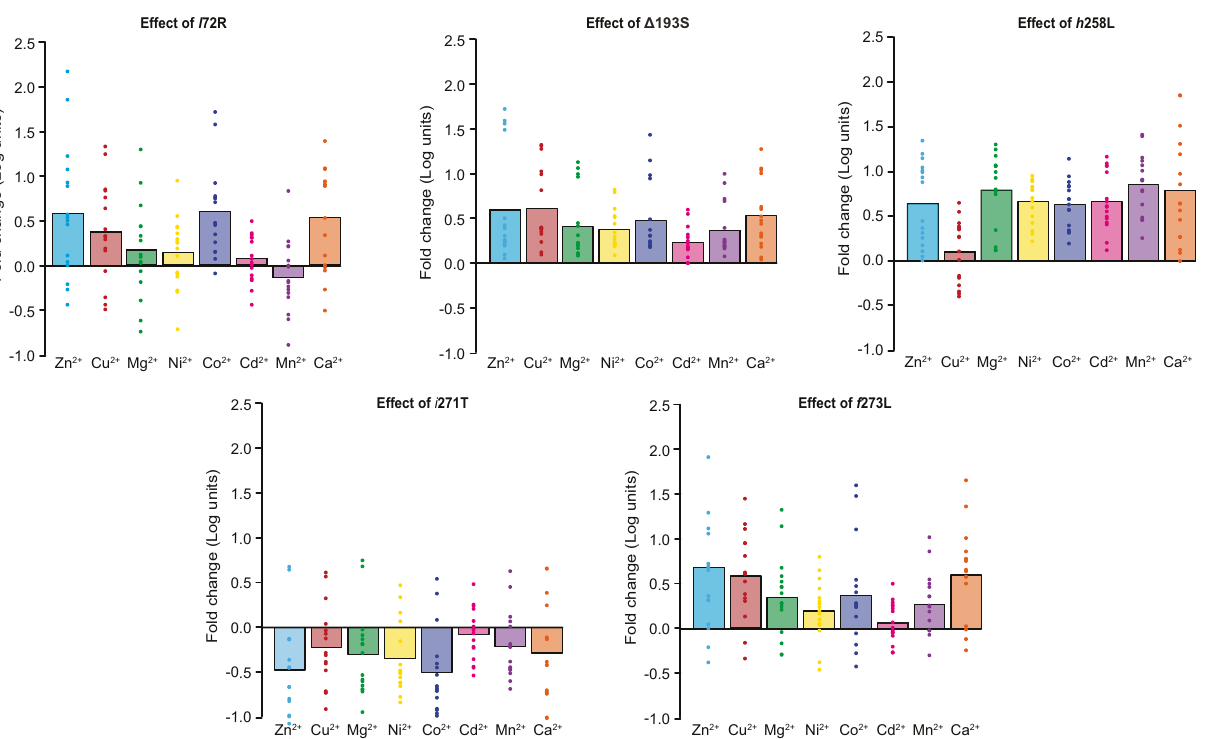
Fig. 4 The average effect of each of the fi ve historical substitutions when introduced in different metal environments. Average effect is shown with solid bars while the effect of each mutation introduced in the 16 alternate genetic backgrounds is shown with dots (each bar therefore representing the corresponding average across all 16 dots for each environment).